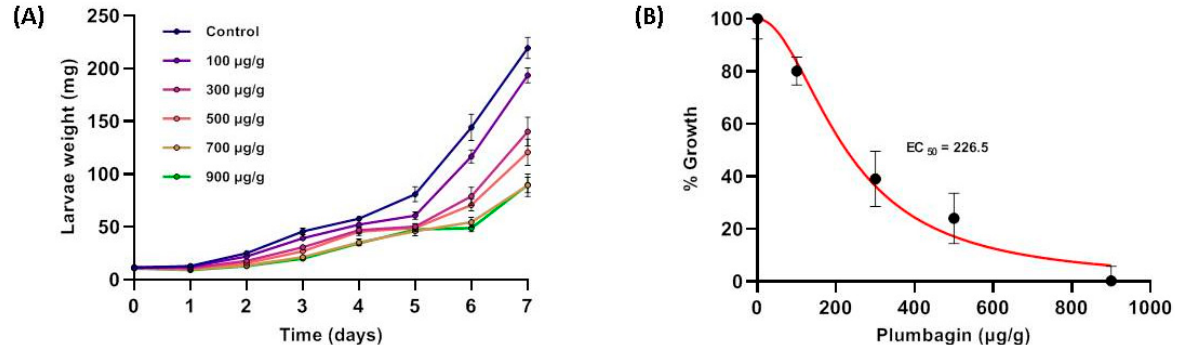
Figure 5. ( A ) Performance of Spodoptera littoralis larvae feeding on artificial diet containing various concentrations of plumbagin. Larvae were weighed every day for 7 days. Mean ( ± SE), n = 15. ( B ) Determination of EC 50 value based on the data obtained in ( A ). EC 50 was calculated with 226.5 and 1.2 µ mol g − 1 diet, respectively.